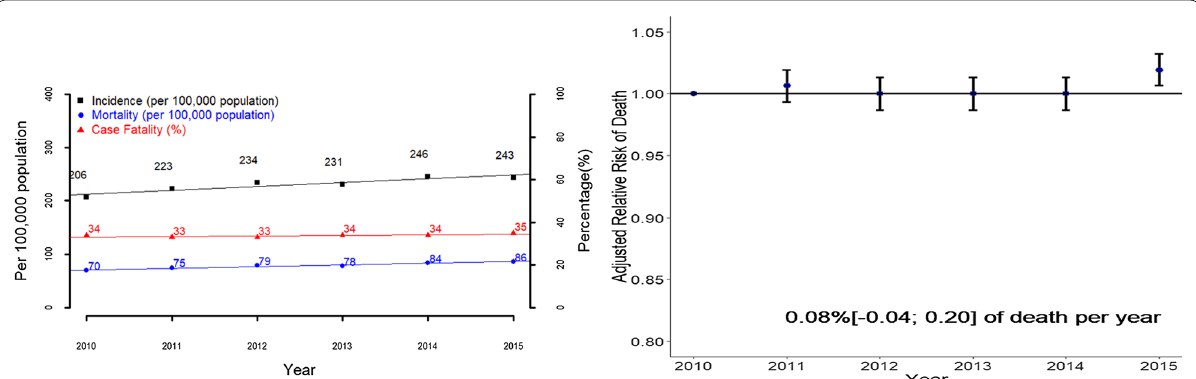
Fig. 2. Incidence, mortality, case fatality from 2010 to 2015 in the whole cohort of patients with sepsis ( a ) and adjusted relative risk of hospital death rate from 2010 to 2015, in the whole cohort of patients with sepsis ( b ). The adjusted relative risk of hospital death was based on the adjusted odd ratio of death obtained by a multivariate hierarchical logistic regression analysis with a random center effect taking into account all the associated factors of hospital death (Additional file 1: Table